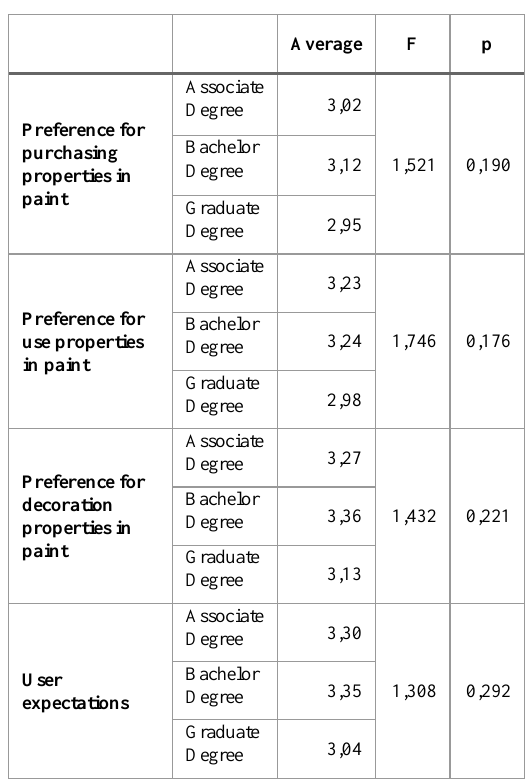
Table 17: ANOVA Test on Consumers' Preferences for Paint by Education Level